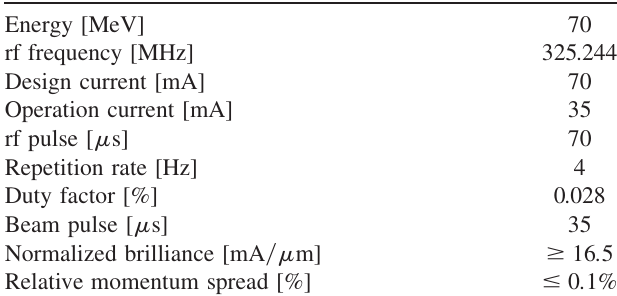
TABLE II. Main parameters of the FAIR proton